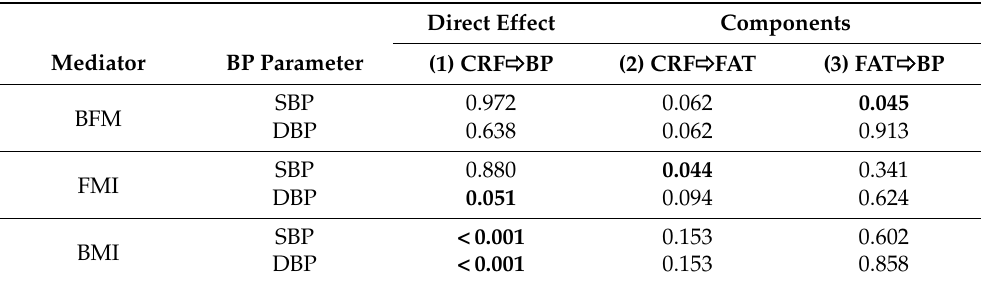
Figure 2. Hypothesized moderation model of potential effects of sex (moderator) on the relationship between CRF and BP through FAT (mediator). Numbers indicate effects of moderation on media- tion model’s elements: 1—sex on indirect influence of CRF on BP, 2—sex on the component: CRF effect on FAT (BFM, FMI, BMI), 3—sex on the component: FAT (BFM, FMI, BMI) effect on BP. Letters indicate effects of mediation: c’—direct effect, a—path an of indirect impact, b—path b of indirect impact. Table 2. Interaction terms of sex on the three arms of mediation models (1–3 on Figure 1) in the relationship between CRF and BP (SBP and DBP) through FAT (BFM, FMI, BMI)— p -values.